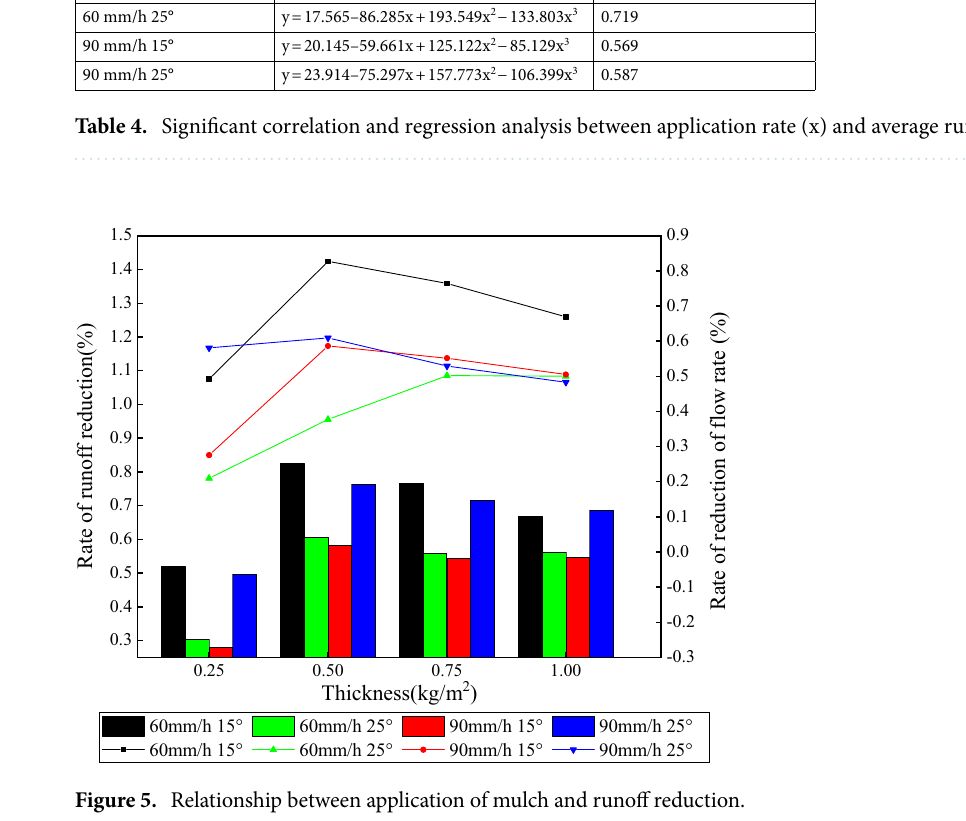
Figure 5. Relationship between application of mulch and runoff